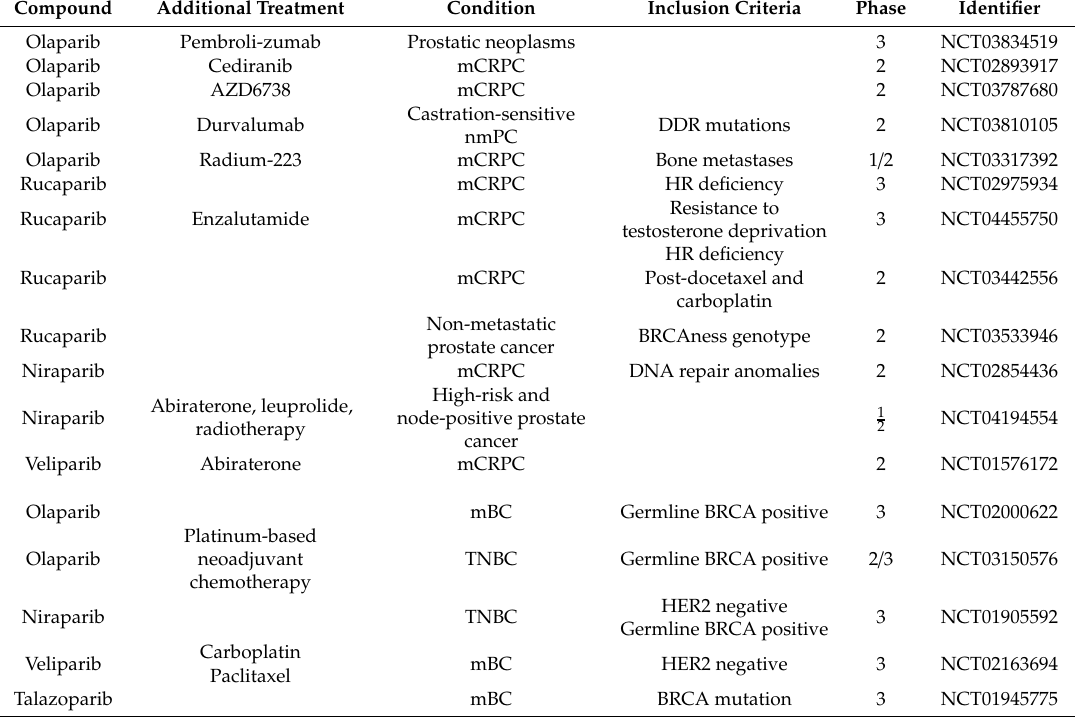
Table 1. Selected clinical trials evaluating poly(ADP-ribose) polymerase 1 (PARP-1) inhibitors in prostate or breast